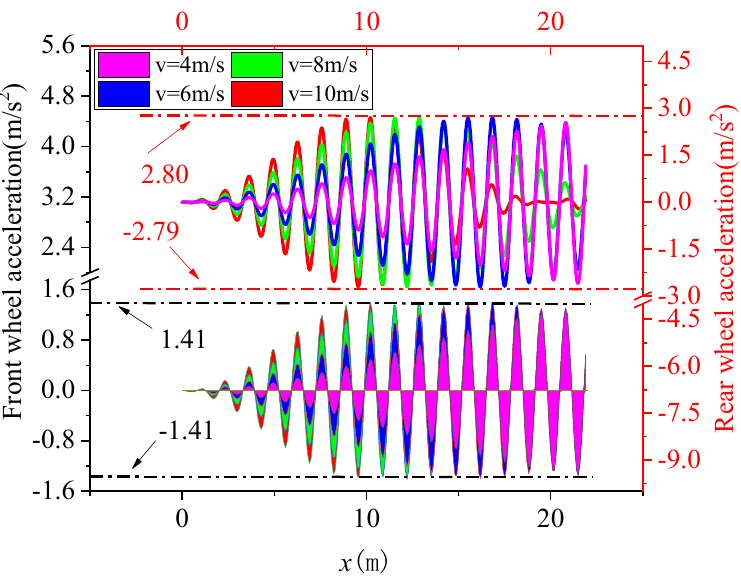
Figure 9. Net vertical acceleration of front and rear wheels at di ff erent speeds 0 ≤ x ≤ ( b + c ).